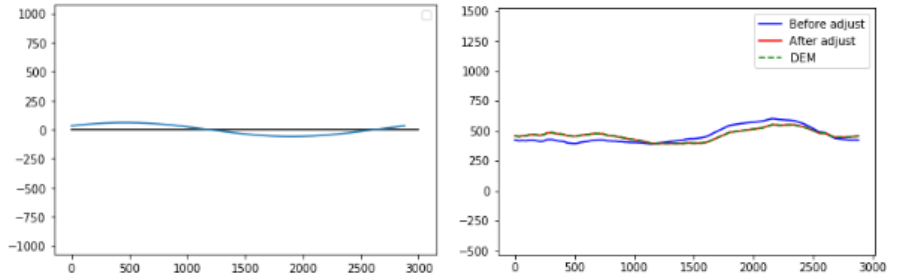
Figure 29. Calibration effect of sinusoidal distortion: ( Left ) The sine curve as fitted in Section 3.3.3; and ( Right ) The effect of calibration. It can be seen that there is a significant difference between the DEM skyline and image skyline before and after calibration.